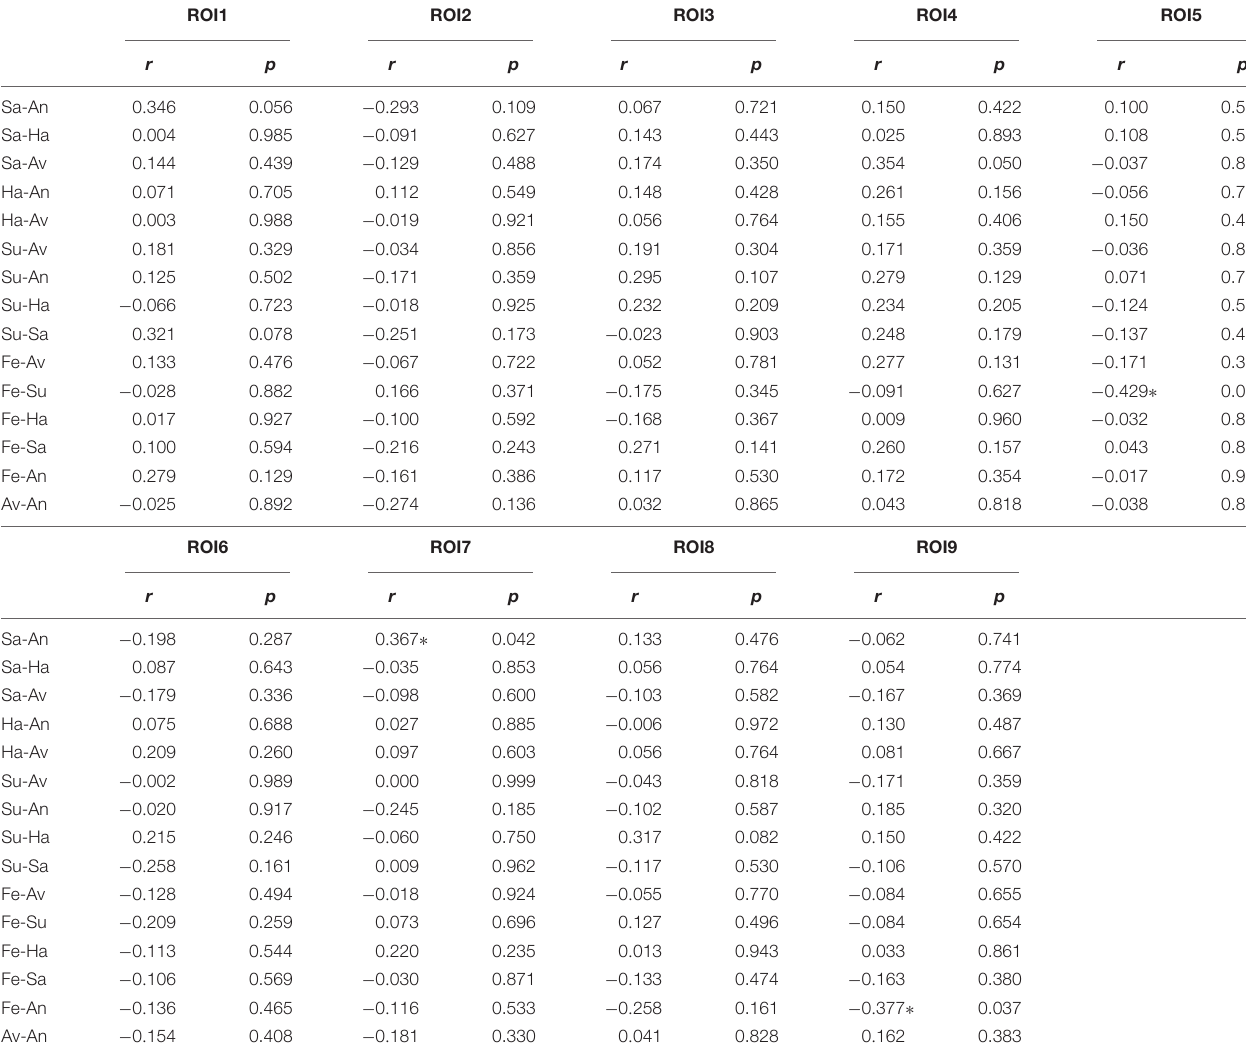
TABLE 6 | Correlation between ReHo value and facial expression recognition